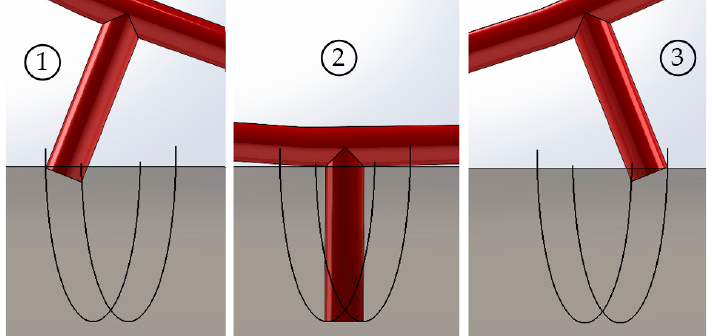
Figure 18. Path taken by the pins in the spiked wheel during a dibbling cycle. Entry position (1), full depth position (2) and exit position (3).